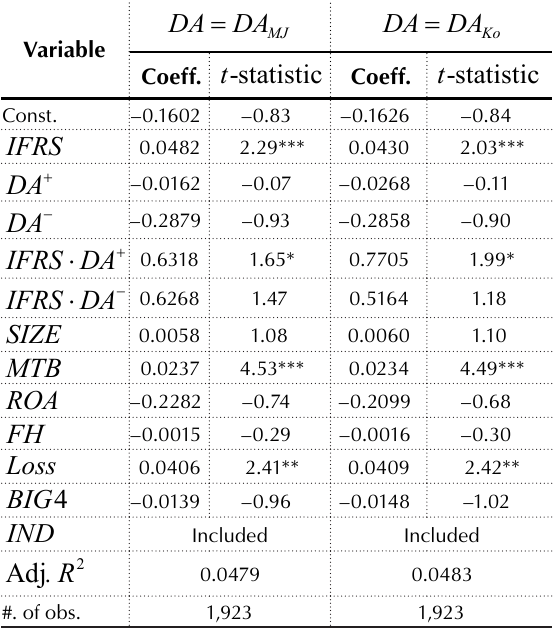
Table 6. Regression analysis